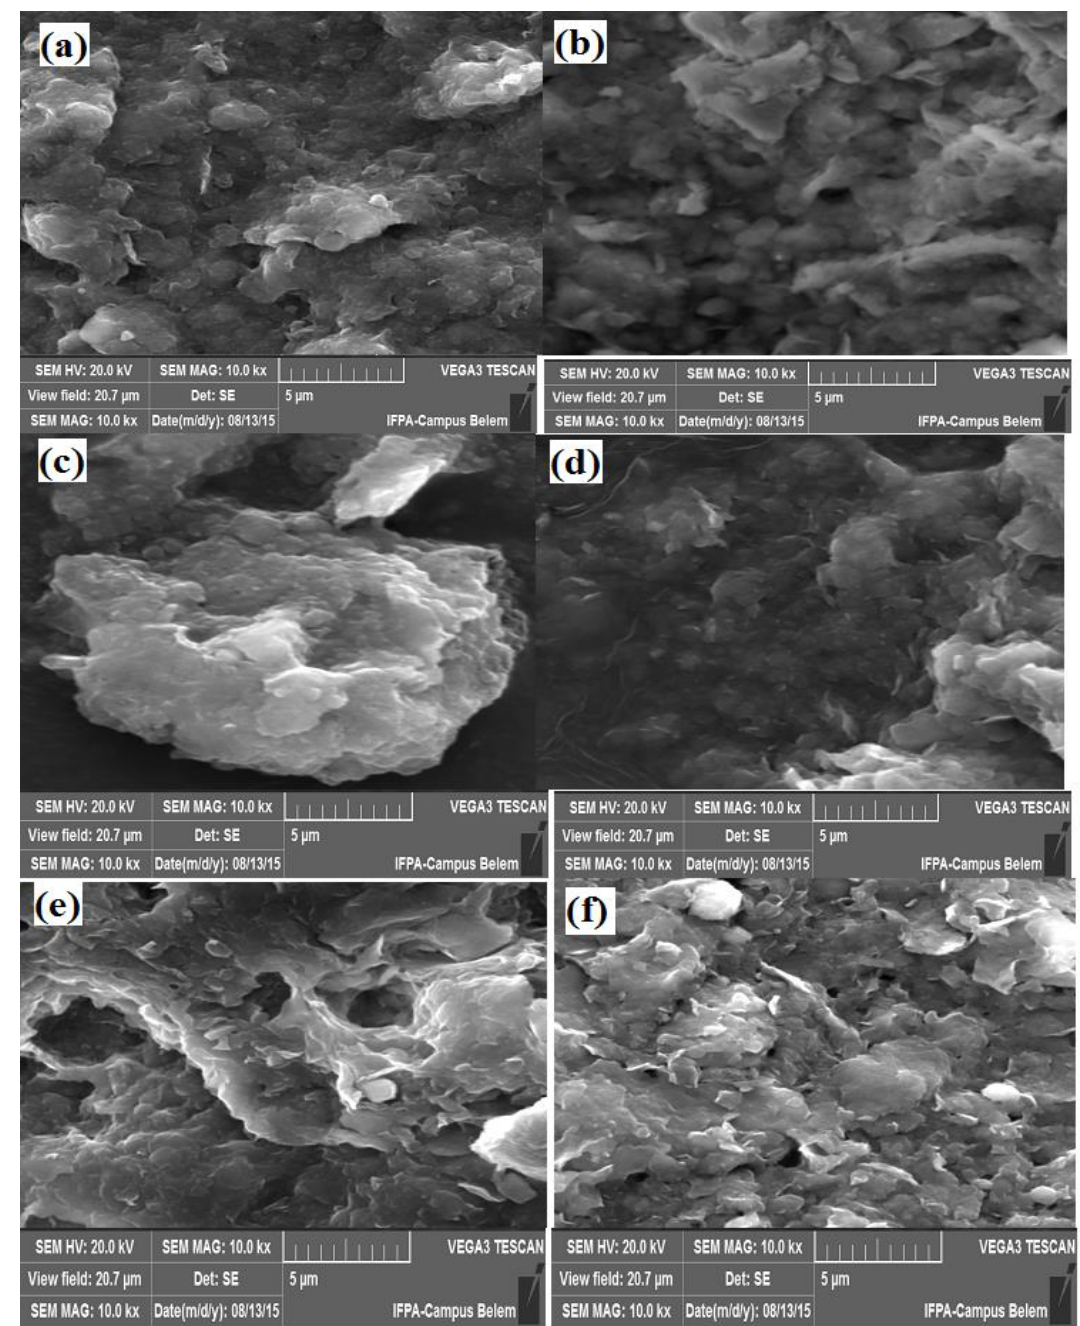
Figure 6. Scanning Electron Microscopy (SEM) micrographs for samples: ( a ) BC, ( b ) BCM, ( c ) BCMW, ( d ) BL, ( e ) BLM ( f ) BLMW.